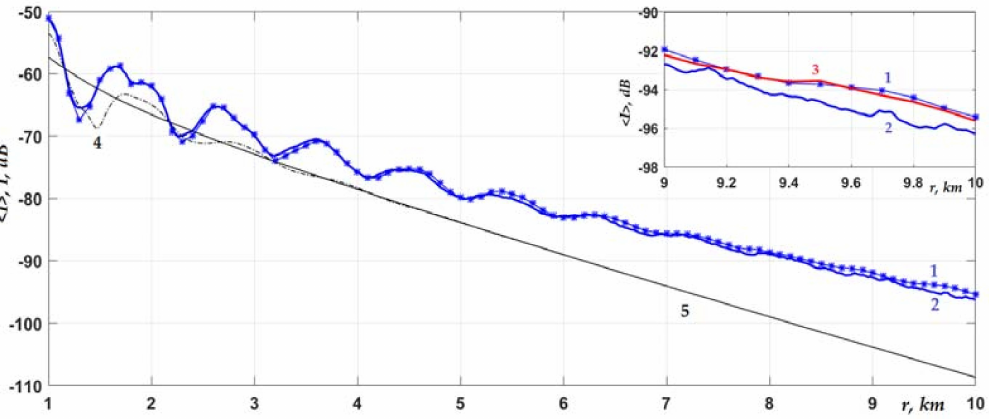
Figure 4. Attenuation of the average intensity is similar to Figures 2 and 3 near the bottom. L rc = 1 km; z = z 0 = 36 m. Curves: 1 (markers) is OW solutions (2) and (3) for δ h = 0; 2 is the OW solution for L h = 100 m; 3 is the OW solution for L h = 1 km; 4 (dots) is intensity in the unperturbed waveguide ( δ c 1 = δ h = 0); 5 is the intensity 4, averaged over the scale of